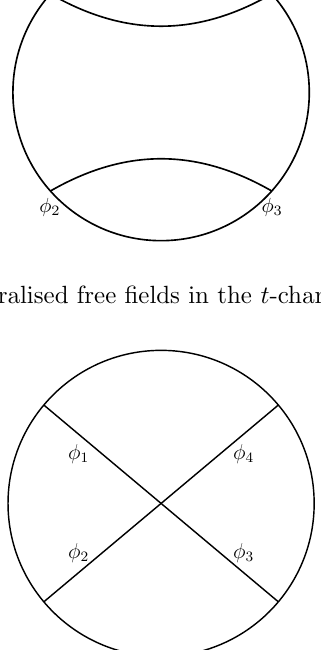
Figure 2 . Four-point contact Witten